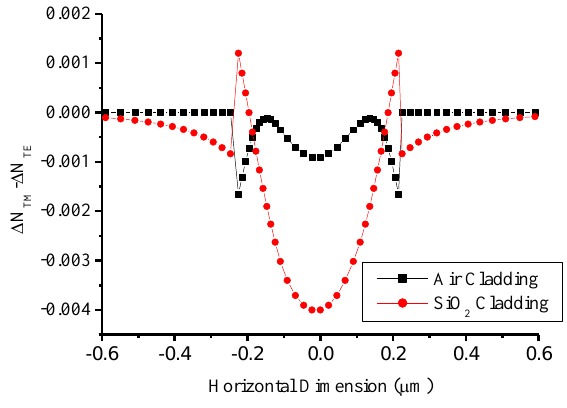
Figure 5. Simulated birefringence caused by the